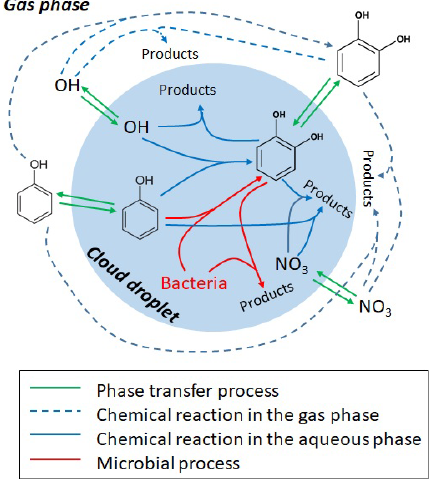
Figure 1. Schematic of the multiphase system in the box